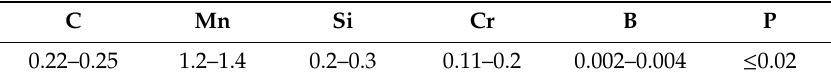
Table 2. Chemical composition of the 22MnB5 steel (wt%).